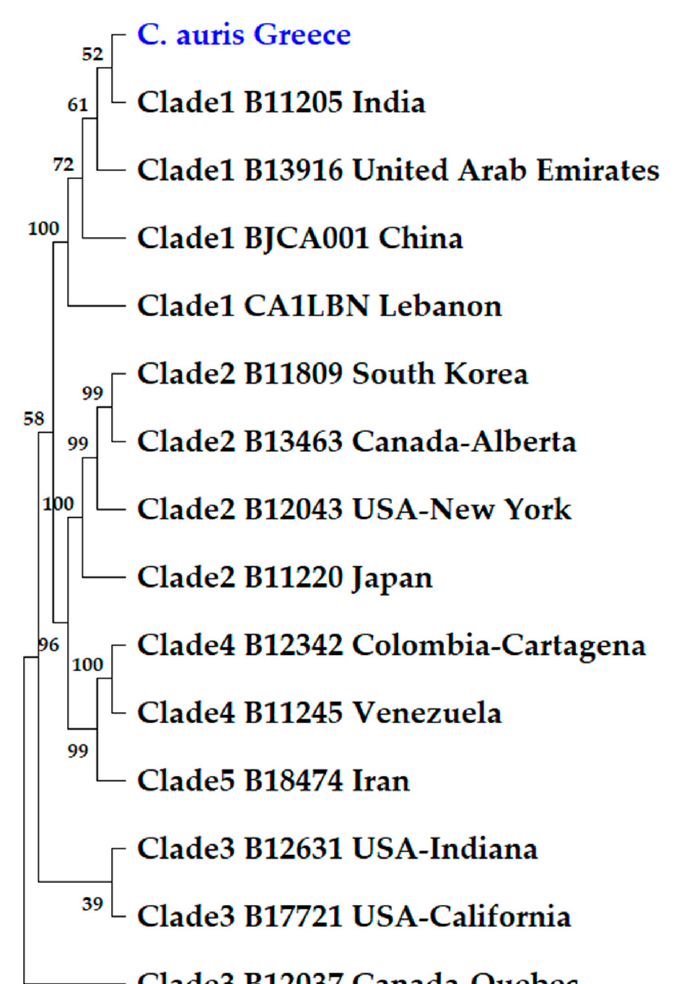
Figure 2. Evolutionary relationships based on the concatenated ITS, RPB1, RPB2 and D1/D2- nucleotide sequences of the C. auris isolates identified in this study and other strains belonging to clades I to V. The identifier C. auris strain names and countries of isolation are depicted. Branches corresponding to partitions reproduced in less than 50% bootstrap replicates were collapsed. The percentage of replicate trees in which the associated taxa clustered together in the bootstrap test (500 replicates) are shown next to the